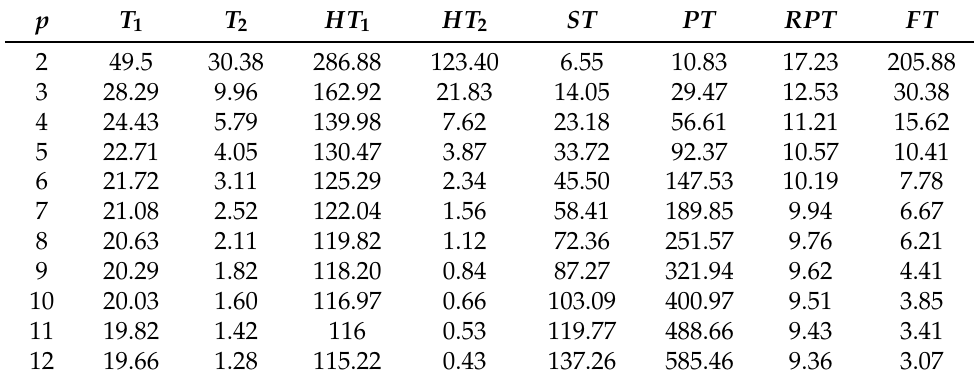
Table 4. Temperature indices of silicate chain network CN p for p ≥ 2.